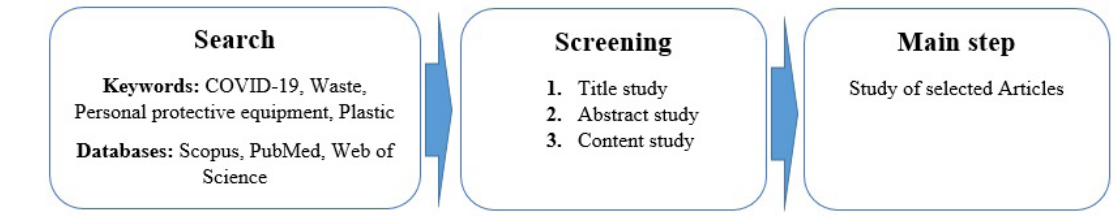
Figure 1. Study process